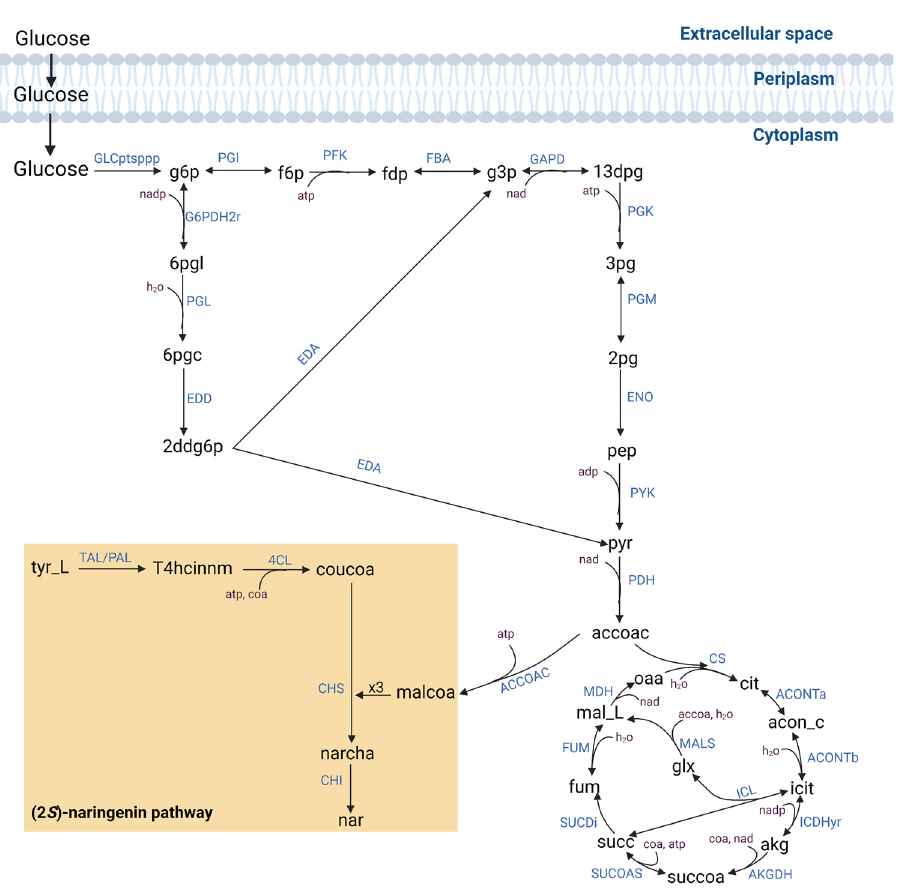
Figure 1. Heterologous pathway for biosynthesis of (2 S )-naringenin in Escherichia coli . Metabolites: pep: phosphoenolpyruvate, pyr: pyruvate, accoac: acetyl-CoA, malcoa: malonyl-CoA, cit: citrate, tyr_L: L-tyrosine, T4hcinnm: p-coumaric acid, coucoa: coumaroyl-CoA, narcha: naringenin chalcone, nar: (2 S )-naringenin. Reaction: PYK: pyruvate kinase, PDH: pyruvate dehydrogenase, ACCOAC: acetyl-CoA carboxylase, CS: citrate synthase TAL: tyrosine ammonia-lyase, PAL: phenylalanine ammonia-lyase, 4CL: 4-coumarate-CoA ligase, CHS: naringenin chalcone synthase, and CHI: chalcone isomerase. Metabolites are shown in black letters. Reactions are shown in blue letters, and the optimized route for (2 S )-naringenin production is presented in the orange